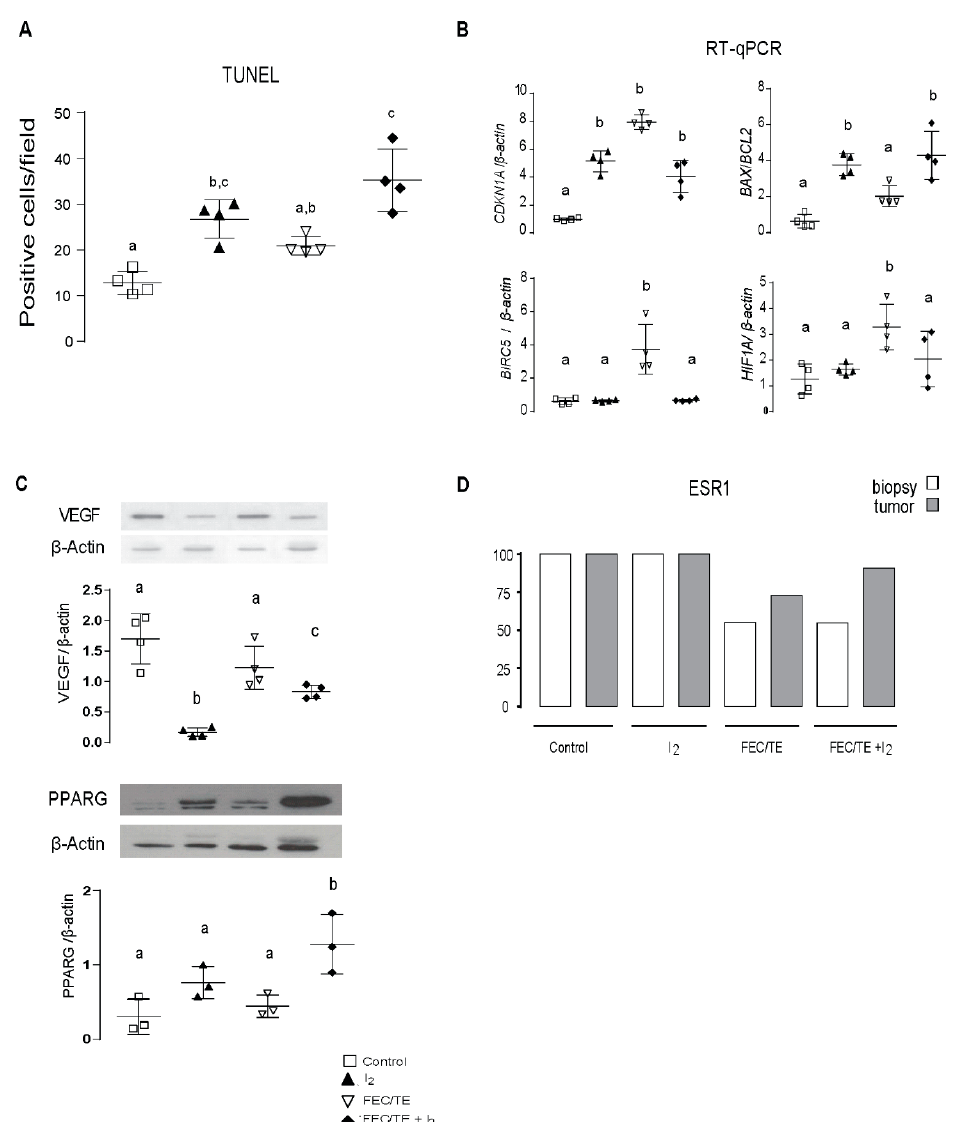
Figure 4. Molecular response to iodine, FEC/TE, or both (FEC/TE+I 2 ) in tumor samples. ( A ) Quantitative results of the TUNEL assay. ( B ) RT-qPCR analysis of cell cycle arrest ( CDKN1A ), apoptosis index ( BAX/BCL2 ), anti-apoptosis ( BIRC5 -Survivin), and hypoxia ( HIF1A ). Each dot represents an individual sample. ( C ) Western blotting analysis of vascular endothelial growth factor (VEGF) and peroxisome proliferator-activated receptor type gamma (PPARG) protein expression. ( D ) Percentage of positive patients with estrogen receptor alpha (ESR1) expression in biopsy and tumor samples. Gene expression was calculated by the 2 - ΔΔ Ct method using β -actin as a housekeeping gene. Data are expressed as mean ± SD. Each dot represents an individual sample, and the di ff erent letters or asterisk indicate significant di ff erences between groups ( P <